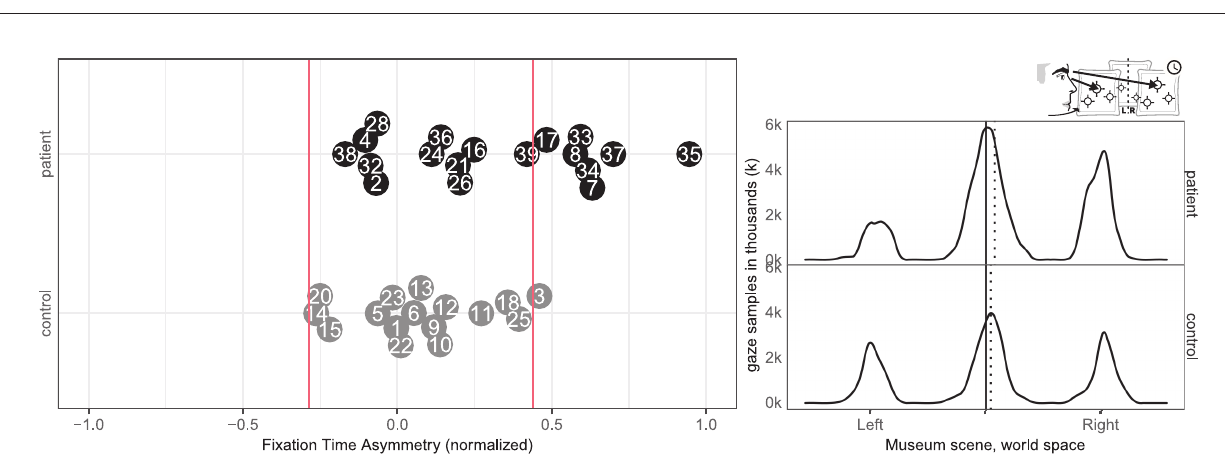
FIGURE 8 | Fixation left/right. (Left) Individual time spent fixating eyes in the left and right for patient (black, top) and control (gray, bottom) with normative threshold cut-offs (red lines). For example, –1 indicates that participants spent 100% of the time fixating on the left. (Right) Time-weighted spatial distribution of patient and control fixations, according to world midline, with time-weighted medians (dotted).